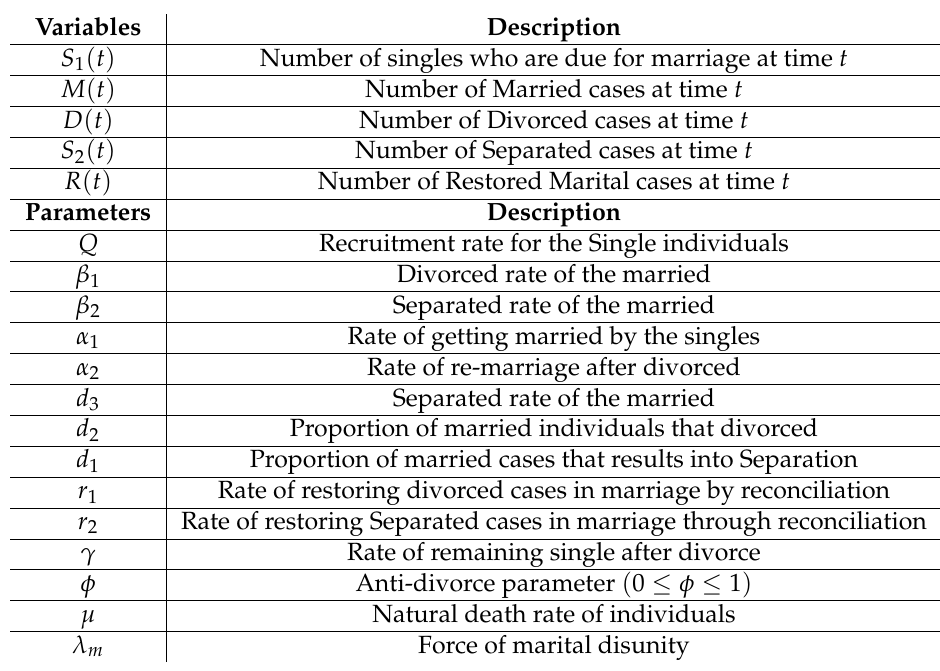
Table 1. Variables and parameters of the model